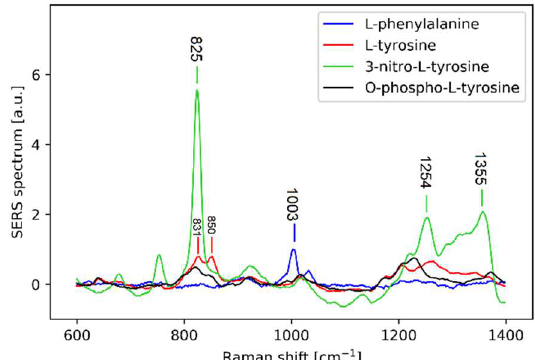
Fig. 3. SERS spectra of selected tyrosine derivatives in the spectral region 600-1400 cm -1 . The SERS spectrum of phenylalanine is included for comparison with Figure 2, and the spectra are normalized on the 1003 cm -1 phenylalanine peak.